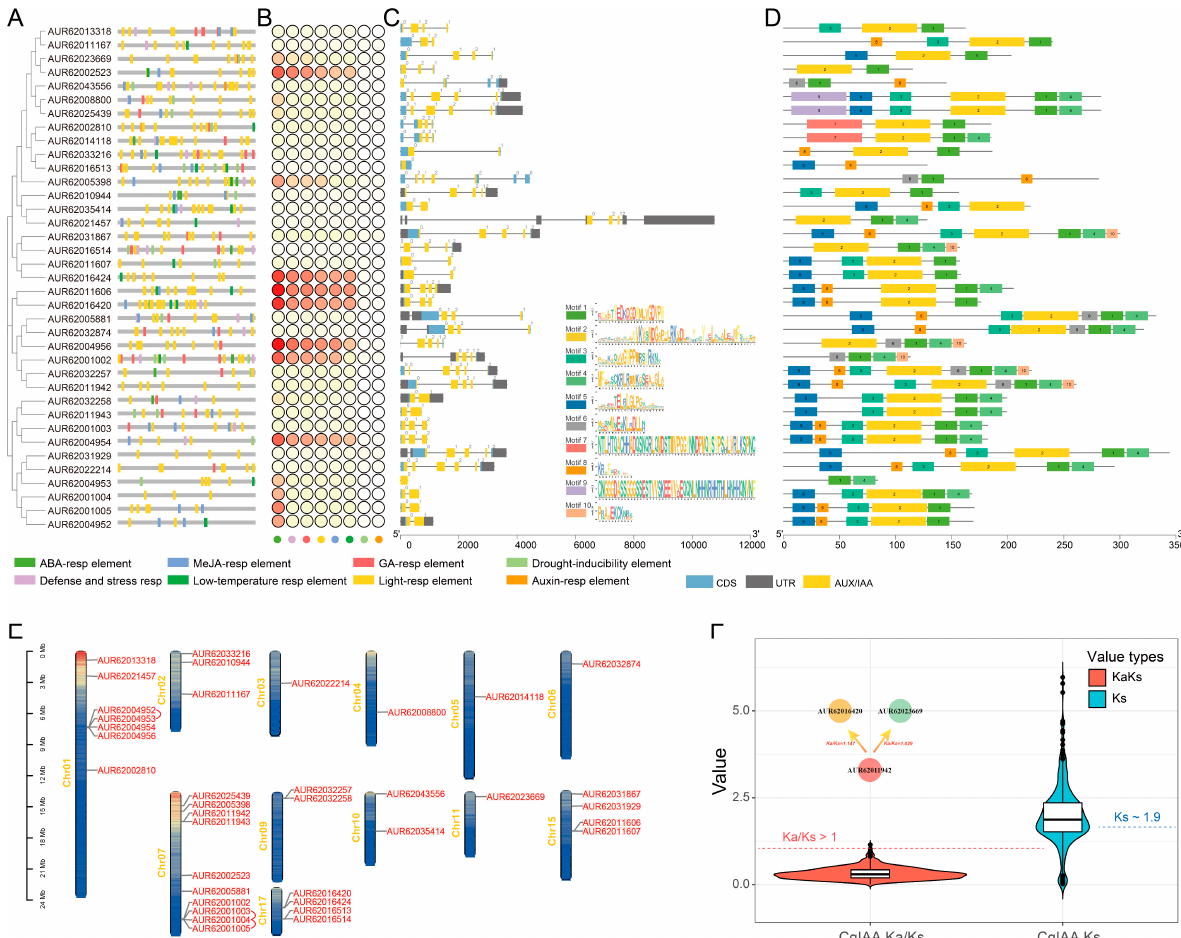
Figure 2. Phylogeny, gene structure, protein motif, chromosomal localization, and evolutionary analysis of quinoa CqIAA protein family. ( A ). Cis-acting element types and distributions in 37 CqIAAs promoter regions. Different color blocks represent different types of cis-acting elements and are distributed within the 2000 bp promoter region; ( B ). Classification statistics of different cis-acting elements; ( C ). The gene structure of 37 CqIAAs is shown: blue, gray, and yellow box repre- sent coding region, noncoding region, and AUX/IAA domain, respectively; black lines represent introns; ( D ). CqIAAs ’ motif structure, the boxes of different colors represent 10 conserved motifs; ( E ). CqIAAs ’ chromosome mapping, the red arcs represent tandem duplication gene pairs; ( F ). Ks and Ka/Ks rate between CqIAA pairs, two pairs of Ka/Ks > 1 IAA gene pairs are shown above the red dotted line; the blue dotted line indicates that the peak Ks distribution of the CqIAA pairs is close to 1.9.